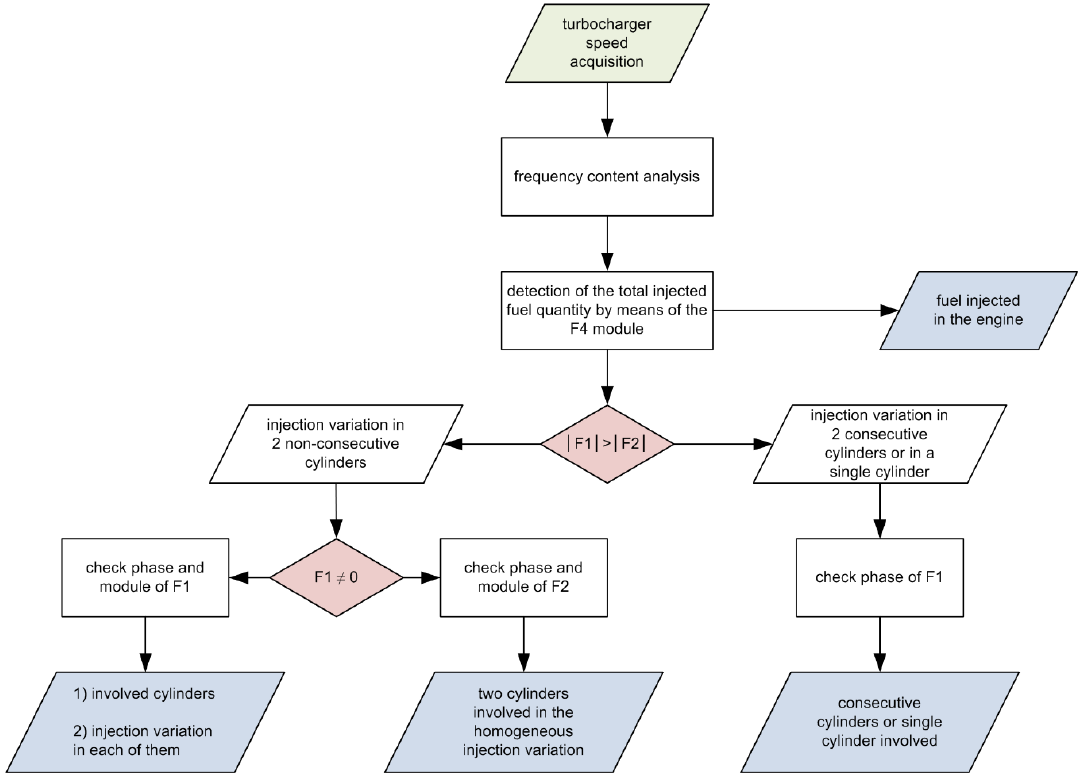
Figure 4. Block scheme of the algorithm for the detection and correction of injectors fault based on the FFT methodology.